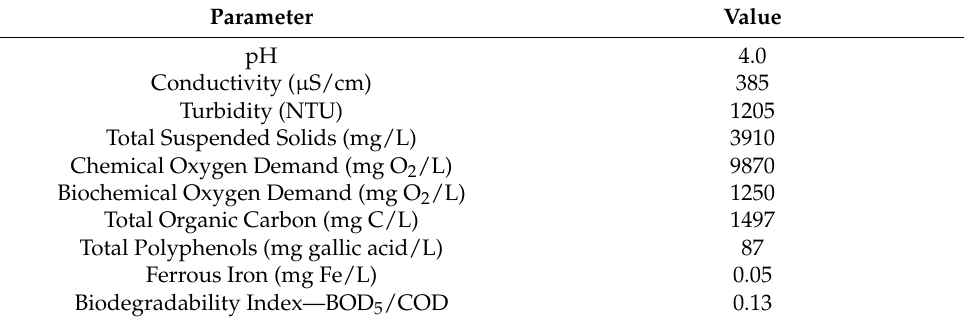
Table 1. Physical–chemical characterization of winery wastewater